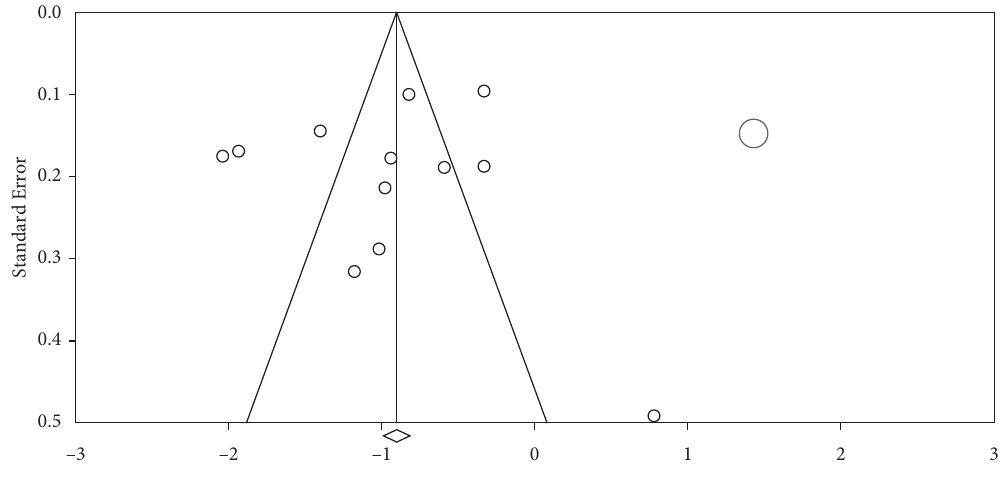
Figure 8: Funnel plot for assessing possible publication